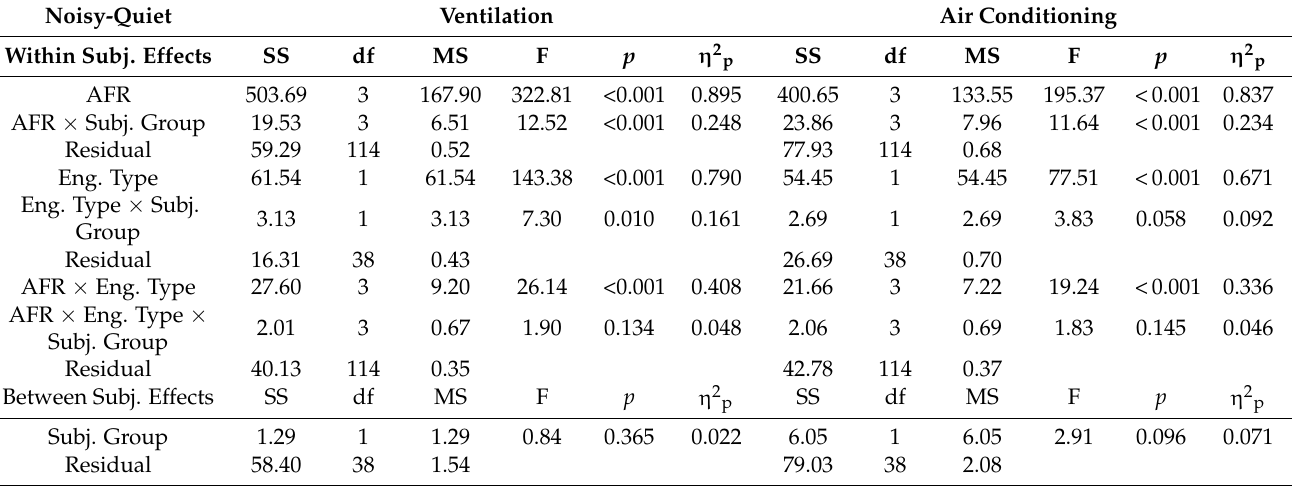
Table 6. ANOVA results for Noisy-Quiet